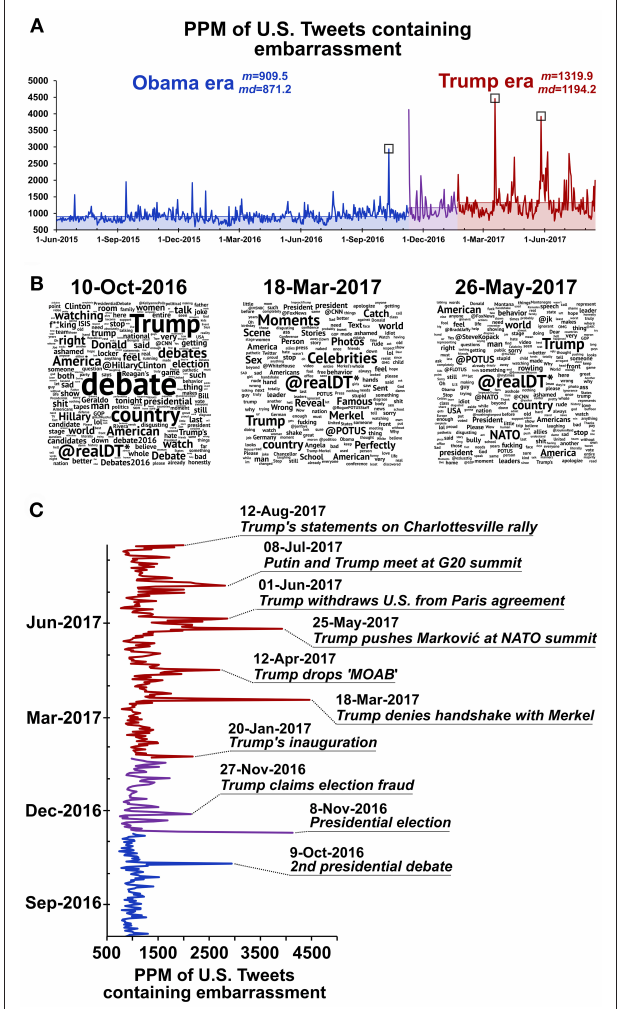
FIGURE 1 | Expression of embarrassment on Twitter in the U.S. (A) Mentions of embarrassment on Twitter between June 1, 2015 and August 13, 2017. The relative number of tweets related to embarrassment increased by ∼ 45% since the start of Trump’s presidency (in red) compared to the last year of Obama’s presidency before Trump was elected (in blue). The purple region of the timeline indicates the period after Trump was elected for office, but before his inauguration. m indicates the arithmetic mean and md indicates the respective median of tweets containing the words “embarrassment” or “embarrassing” or “embarrassed” during Trump’s and Obama’s presidency, including retweets. The y-axis refers to parts per million (ppm) of all tweets sent from U.S. Twitter accounts. (B) Word clouds demonstrating the association between embarrassment and Trump for three selected dates. Word clouds were computed from tweets (excluding retweets) for days when there was a high volume of tweets about embarrassment [see boxes on peaks in (A) October 10, 2016 (44,389 tweets); March 18, 2017 (39,072 tweets); and May 26, 2017 (49,653 tweets)]. Word clouds show strongest associations with Donald Trump and related political events (e.g., “debate,” “Merkel,” “NATO”) but also references to the U.S. (e.g., “country,” “America”) or his representational claim (e.g., “president,” “leader”). Word size is scaled by the word count in these tweets after removing common English words (e.g. “the,” “over,” “take,” “after,” and “you”) and the search terms “embarrassment,” “embarrassing,” and “embarrassed” using the WordArt.com (https://wordart.com) software framework. @realDT* refers to @realDonaldTrump and was shortened for